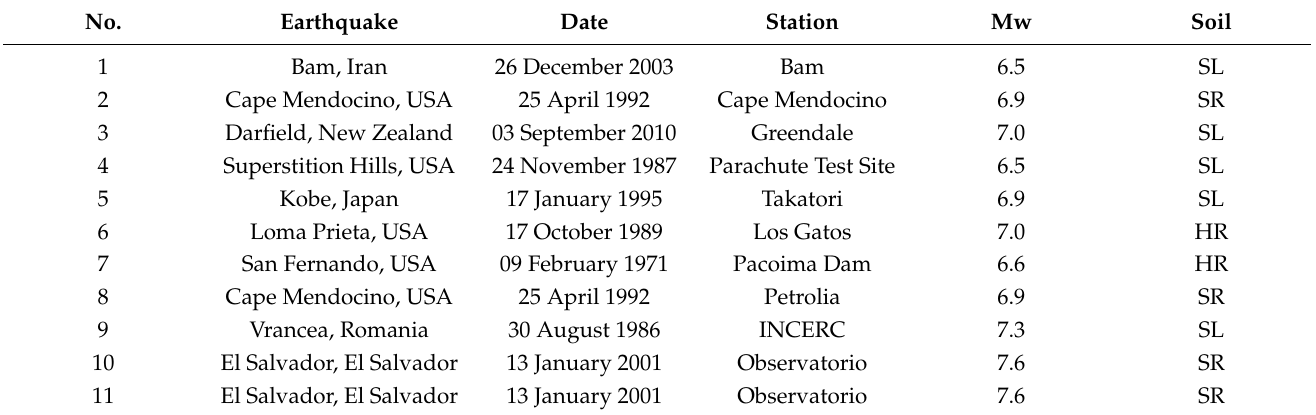
Table 3. Seismic